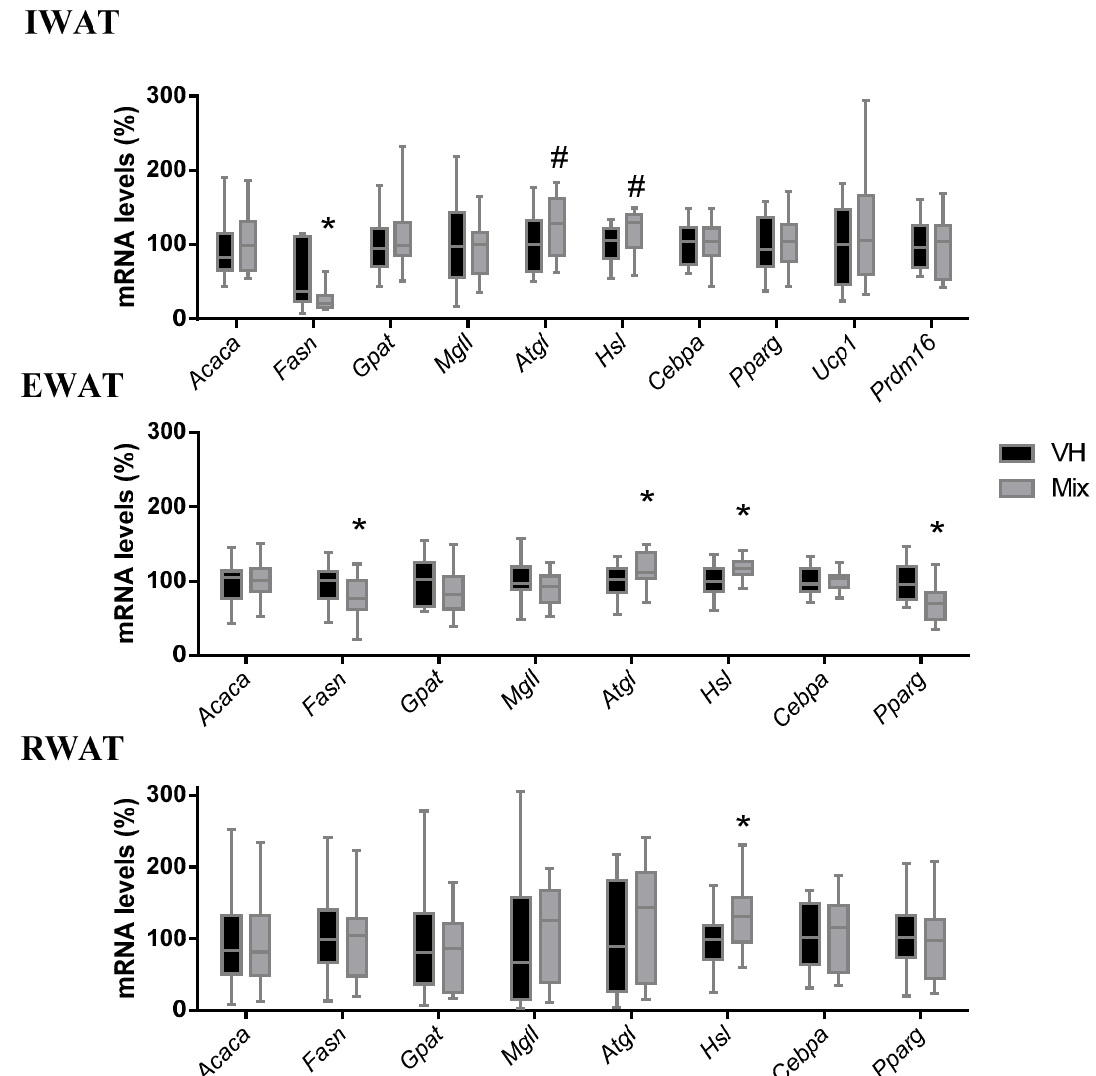
Figure 3. Expression of genes related to lipogenesis, lipolysis, adipogenesis, and thermogenesis in the IWAT, EWAT, and RWAT of Wistar rats fed a CAF diet for 11 weeks and supplemented with the vehicle or a mix of ingredients containing GSPE, anthocyanins from bilberry and blackcurrant, CLA, and CFH during the last three weeks. Data are presented as the ratios of gene expression, relative to β -actin, Ppia , and Hprt and expressed as a percentage of the VH group, set at 100%. Box plots represent the median and Tukey whiskers ( n = 16), and data were compared with Student’s t -test (* p < 0.05, # p < 0.1).